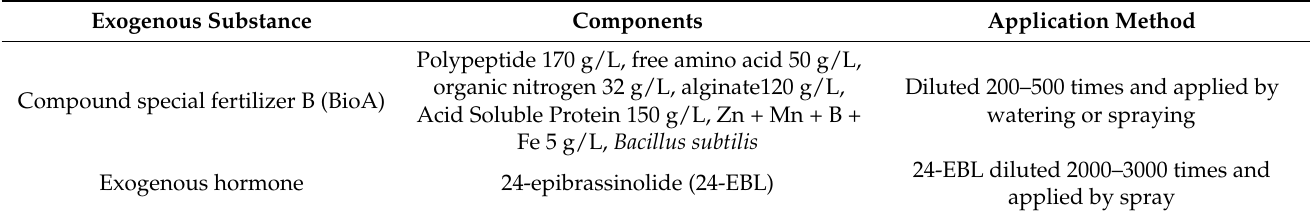
Table 2. Exogenous substance